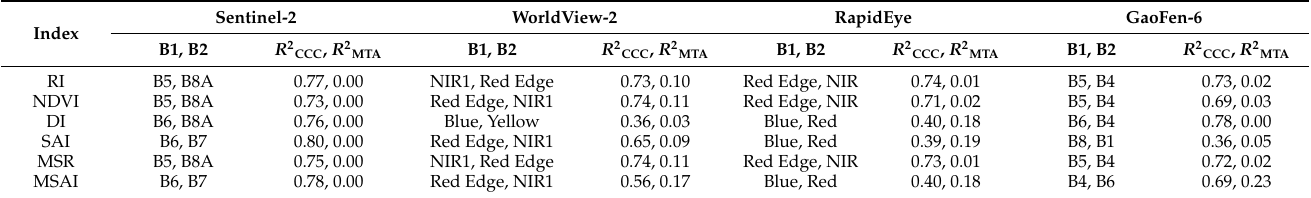
Table 5. Best band configurations for the two-band indices in the field measured dataset for each simulated satellite.